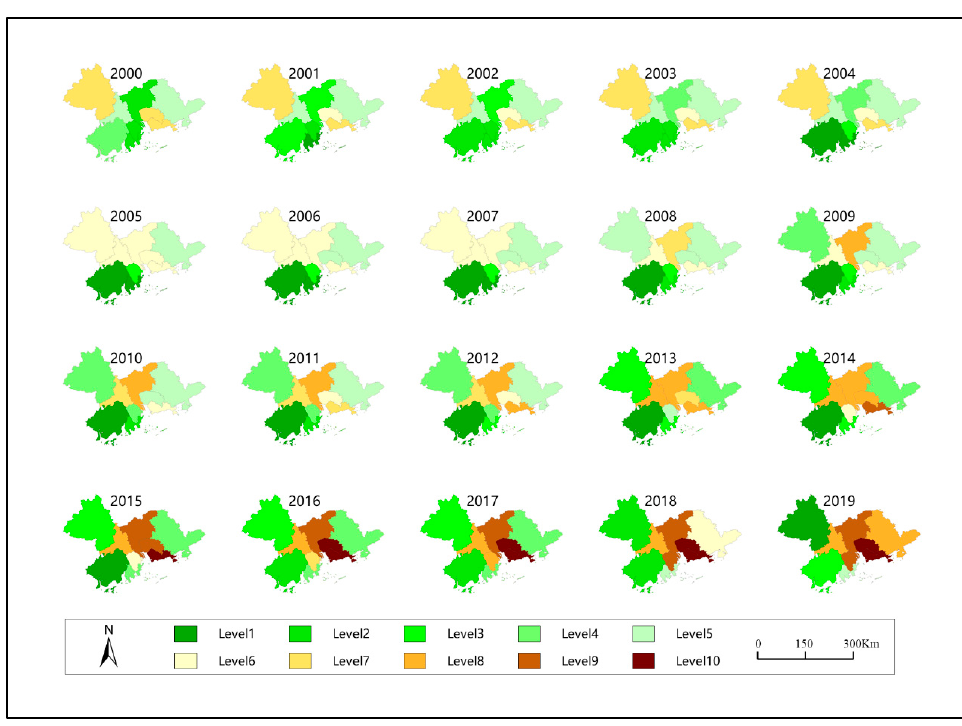
Figure 3. Level of the GTWR coefficient of R & D on the development of manufacturing in different years.